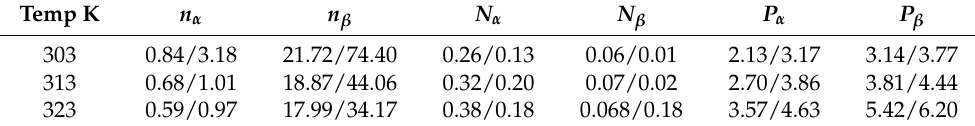
Table 3. Adjusted model parameter values for absorption processes according to the best fitting model (Model 2), where values xx/yy correspond to LaNi 5 and LaNi 4.75 Pb 0.25 , respectively.